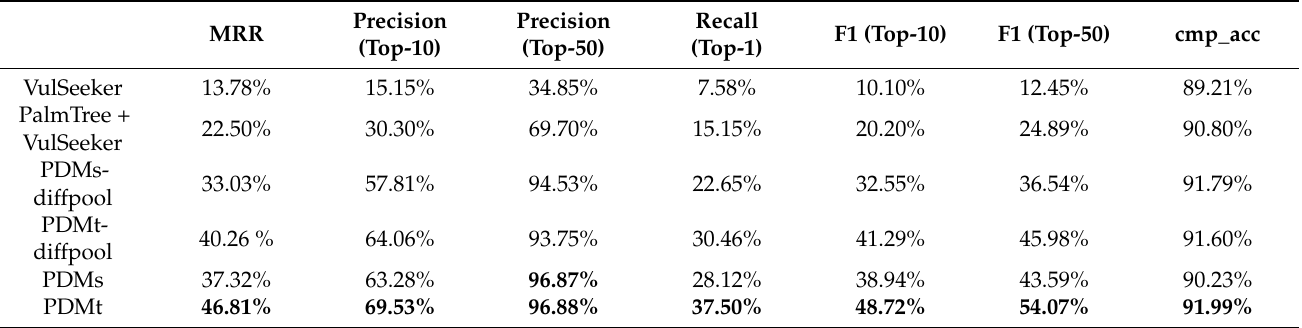
Table 1. Accuracy on the general dataset.